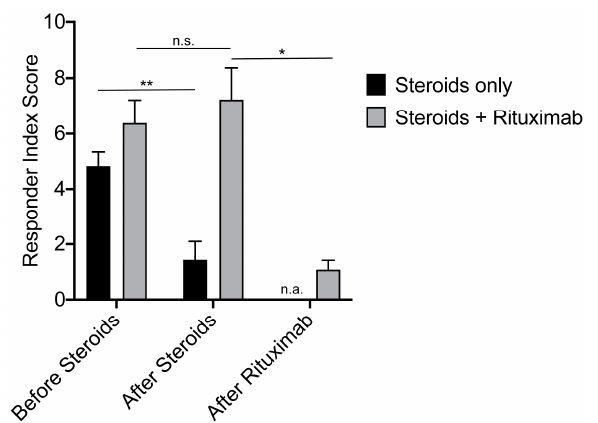
Figure 4. Treatment response, measured by the RI in patients treated either with steroids or with steroids and subsequent RTX. RI scores were evaluated (i) before the initiation of steroid therapy, (ii) after the termination of steroids and (iii) after RTX therapy; * p < 0.05, ** p < 0.01, n.s. not